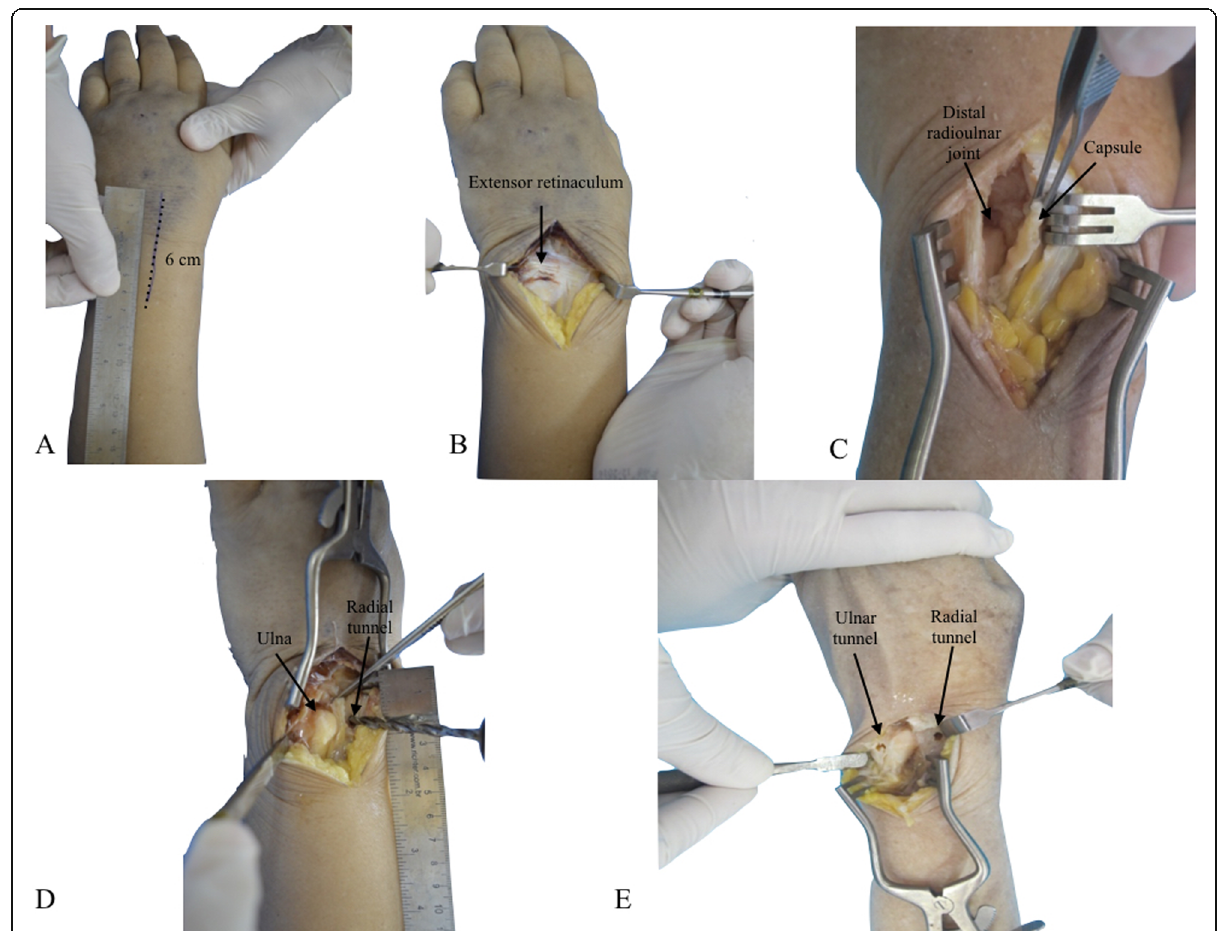
Fig. 1 a Dorsal view of the wrist with the marked skin incision; ( b ) Dorsal view depicting the extensor retinaculum; ( c ) L-shaped capsulotomy with joint exposure; ( d ) Radial tunnel drilling; ( e ) Dorsal view of the wrist showing the radial and ulnar